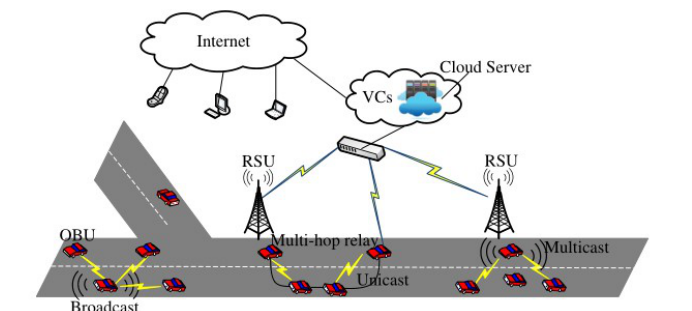
Figure 1. The structure of a